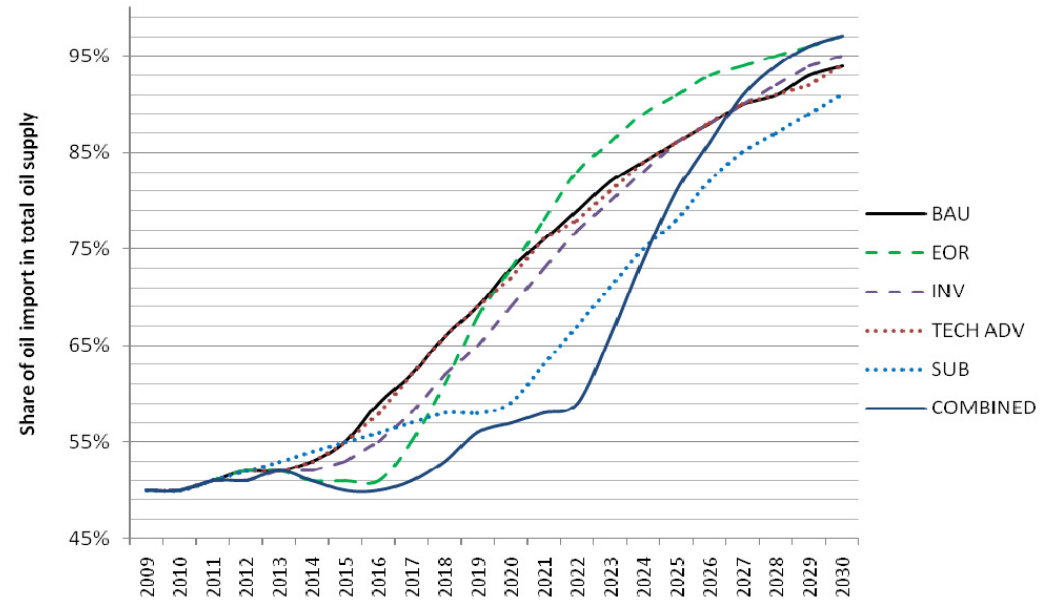
Figure 22. Malaysia’s oil import share in its total oil